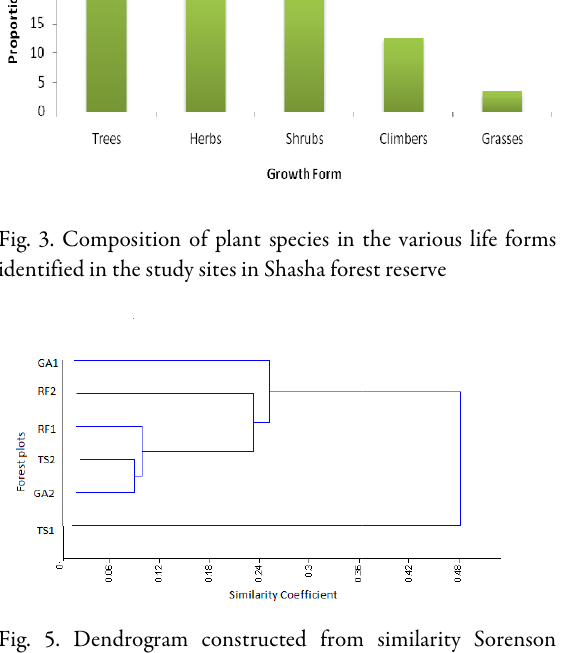
Fig. 5. Dendrogram constructed from similarity Sorenson Dendrogram constructed from similarity Sorenson Index matrix based on species composition in the various plots Index matrix based on species composition in the various within the site